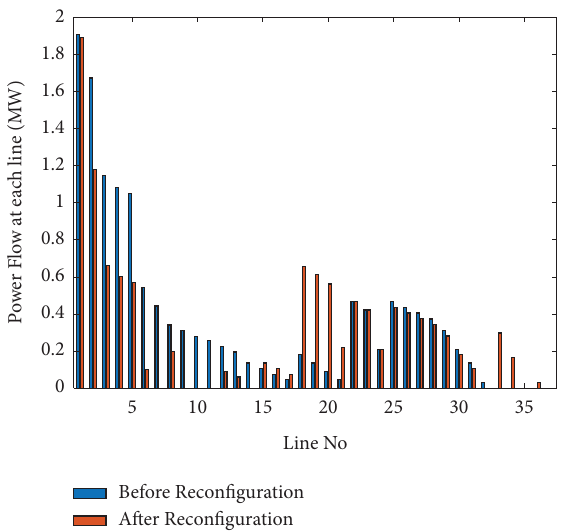
Figure 5: Power fow at each line in a 33-bus system light load before and after